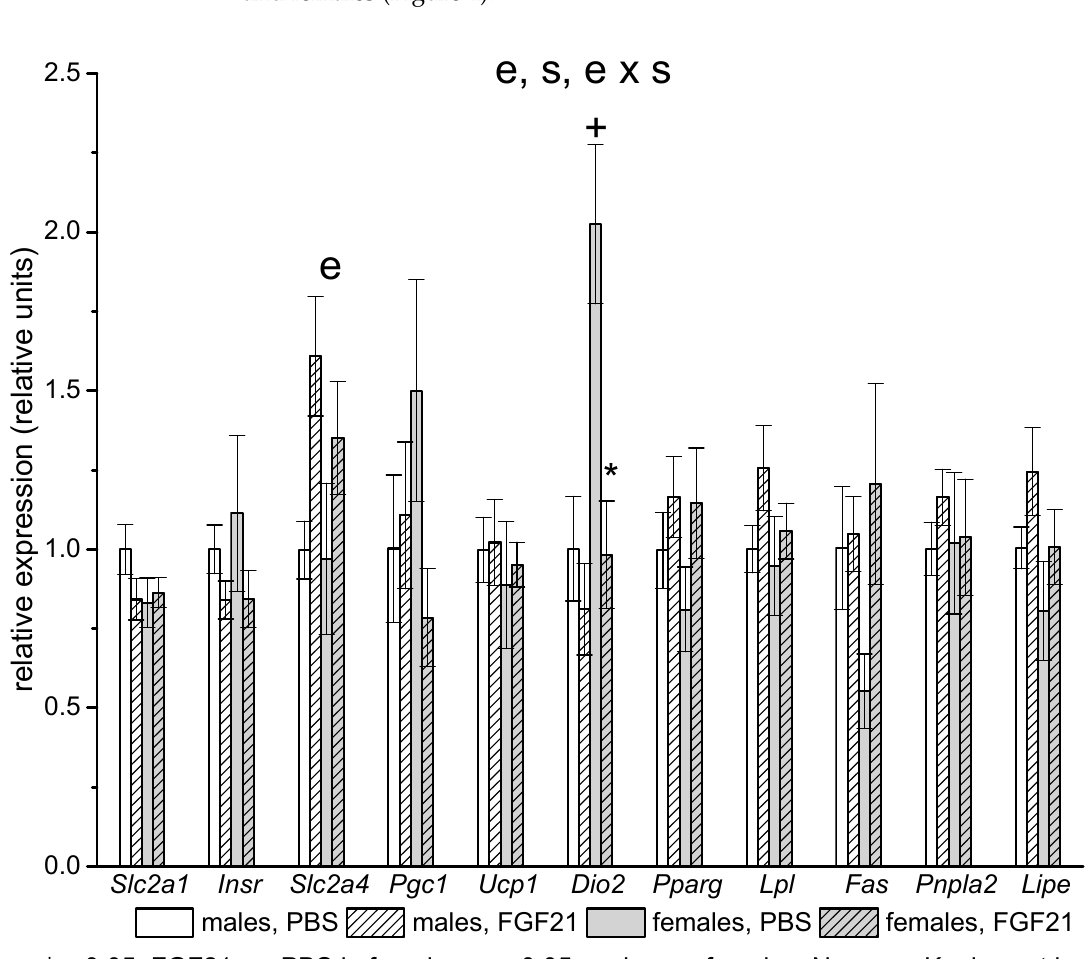
Figure 4. Influence of FGF21 administration on iBAT gene expression in male and female obese mice. Data are presented as mean ± SEM. Mice were administered FGF21 for 7 days. Significant influences of factor “e” (administration of PBS or FGF21), “s” (sex), and “e × s”, two-way ANOVA, are indicated in the plot.